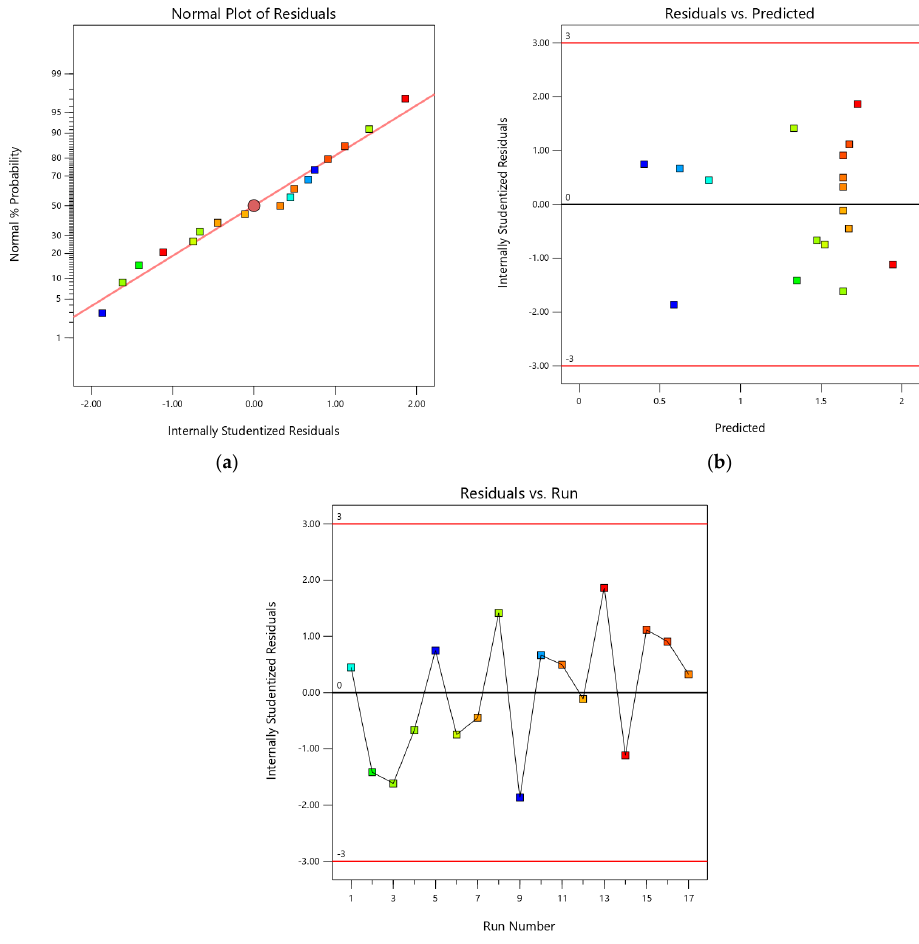
Figure 2. ( a ) The normal probability plot of residuals, ( b ) plot of internally studentized residuals versus experimental runs, and ( c ) plot of predicted and actual values.